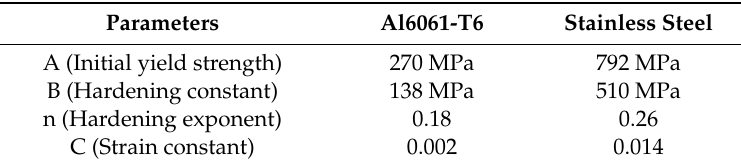
Table 2. Constants of Johnson–Cook model for the dummy and sensor.